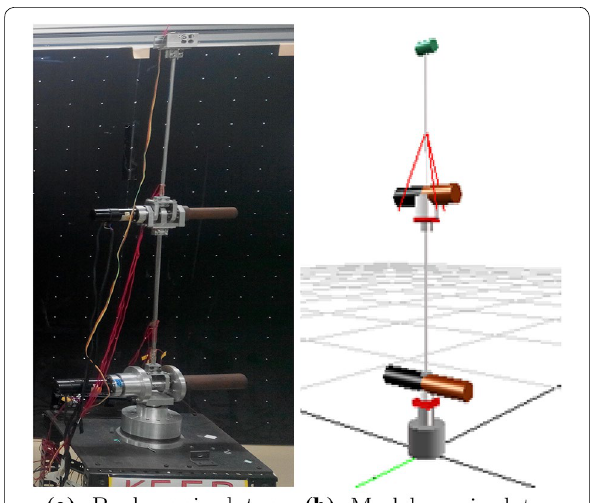
Fig. 2 Manipulator model The manipulator comprises of two flexible links whose joints are driven by dc servomotors and sitting on a rotary joint giving it a 3D motion. Details about the flexible links and the description of the accessories are as tabulated in Appendix